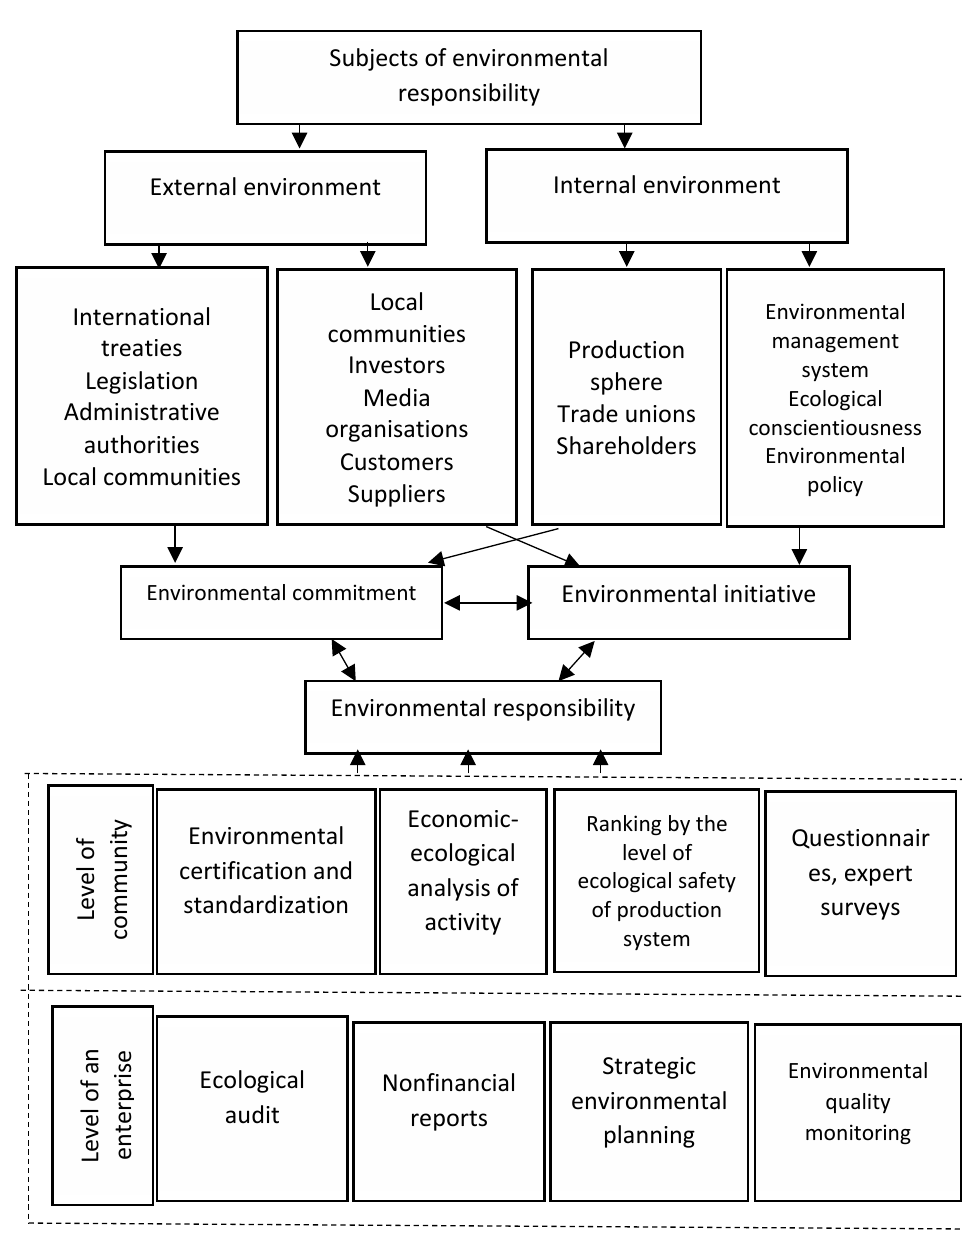
Fig. 3: Organizational-economic support of environmental responsibility of industrial enterprises